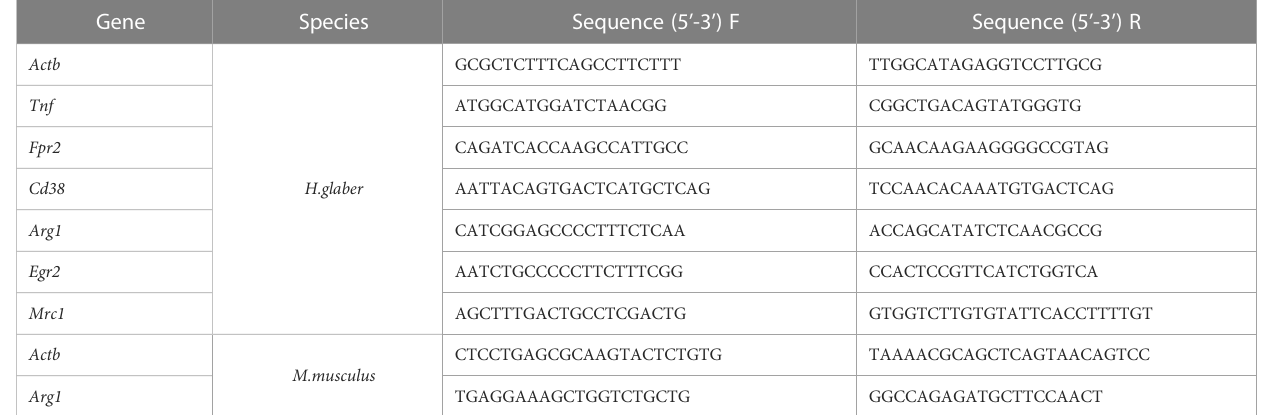
TABLE 1 RT-qPCR primers used in study.